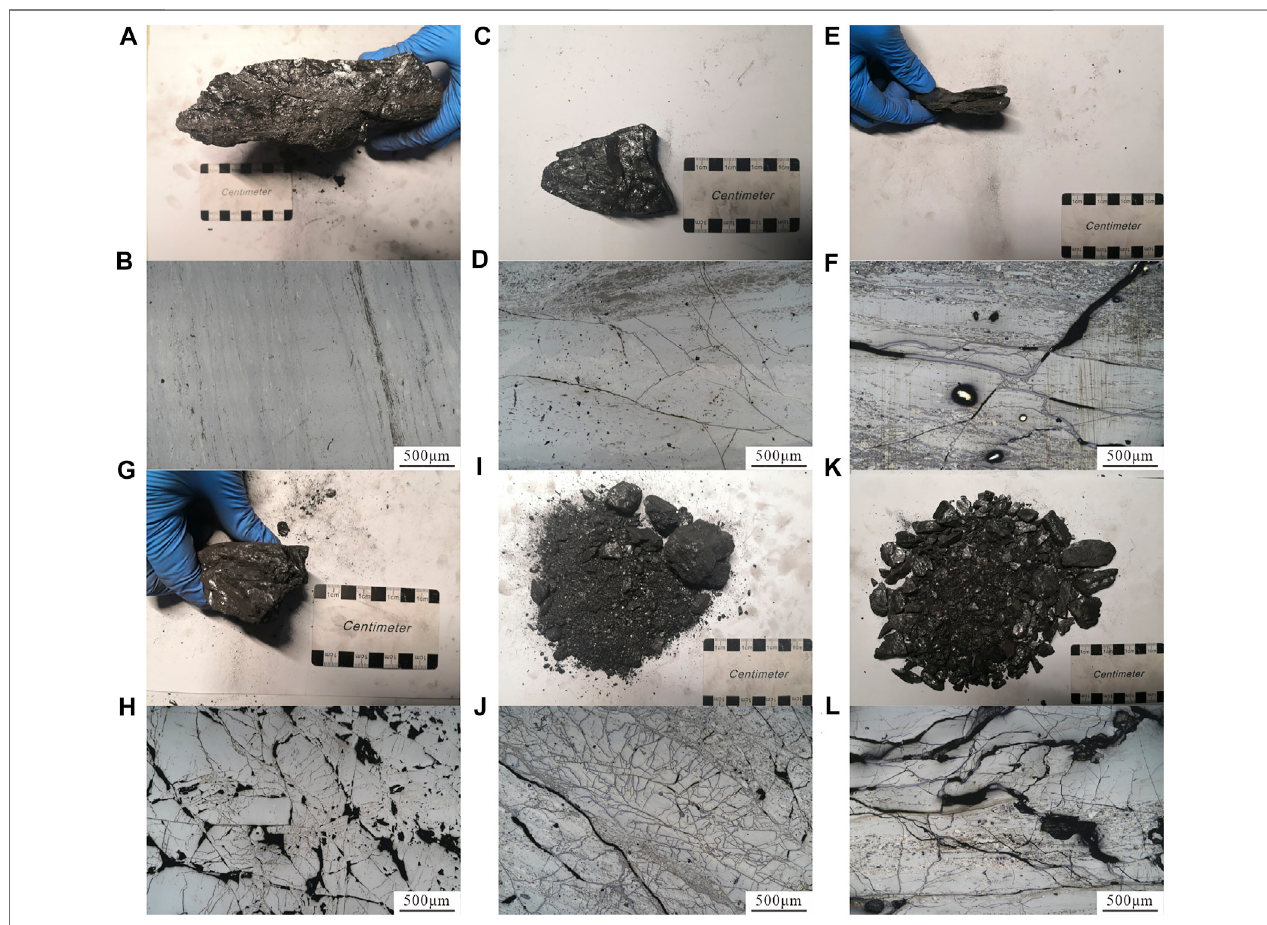
FIGURE1| Themicro-andmacrodeformationcharacteristicsofcoalsamples. (A) – (B) sampleWG-6,primarycoal; (C) – (D) sampleWG-4,cataclasticcoal; (E) – (F) sample QYZ-70, schistose coal; (G) – (H) sample RL-2, motar coal; (I) – (J) sample QD-3, granulitic coal; (K) – (L) sample QYZ-86, fl aky coal; (A) , (C) , (E) , (G) , (I) , (K) photos of hand specimens; (B) , (D) , (F) , (H) , (J) , (L) photos obtained under the re fl ected light of the optical microscope, ×50.